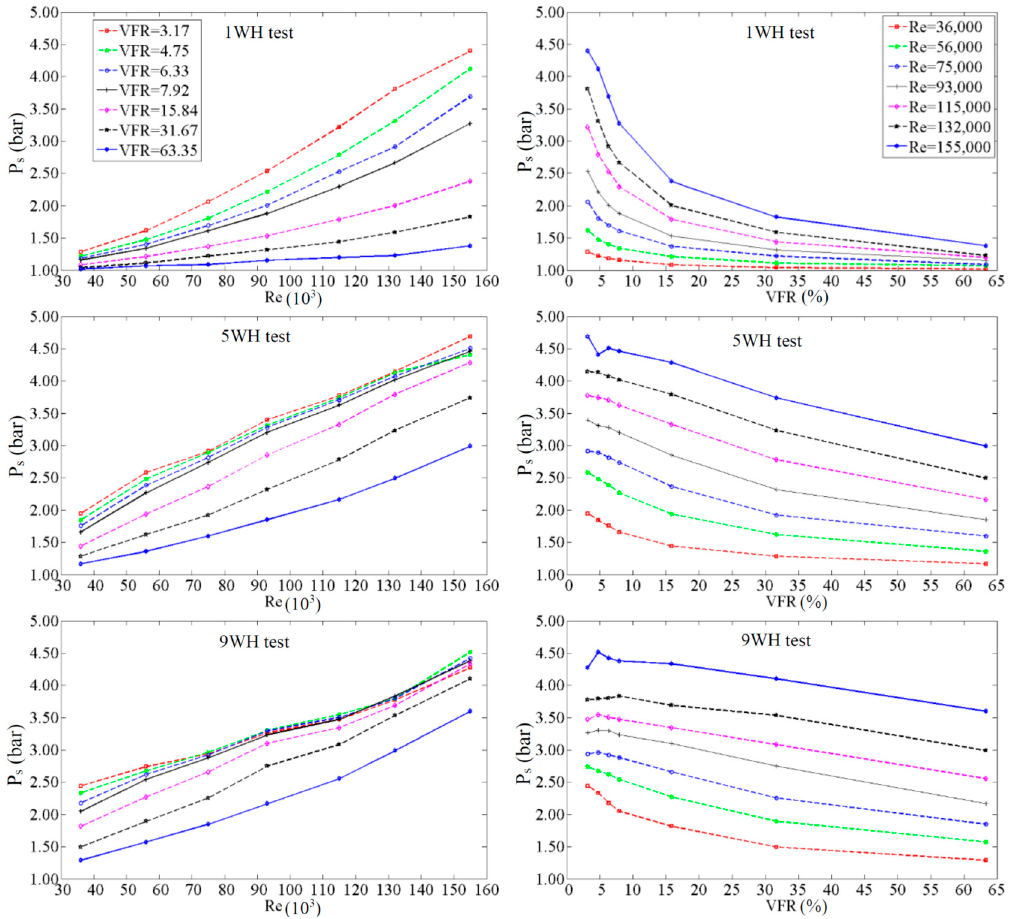
Figure 7. Stored pressure change against Re and VFR for various WH tests.